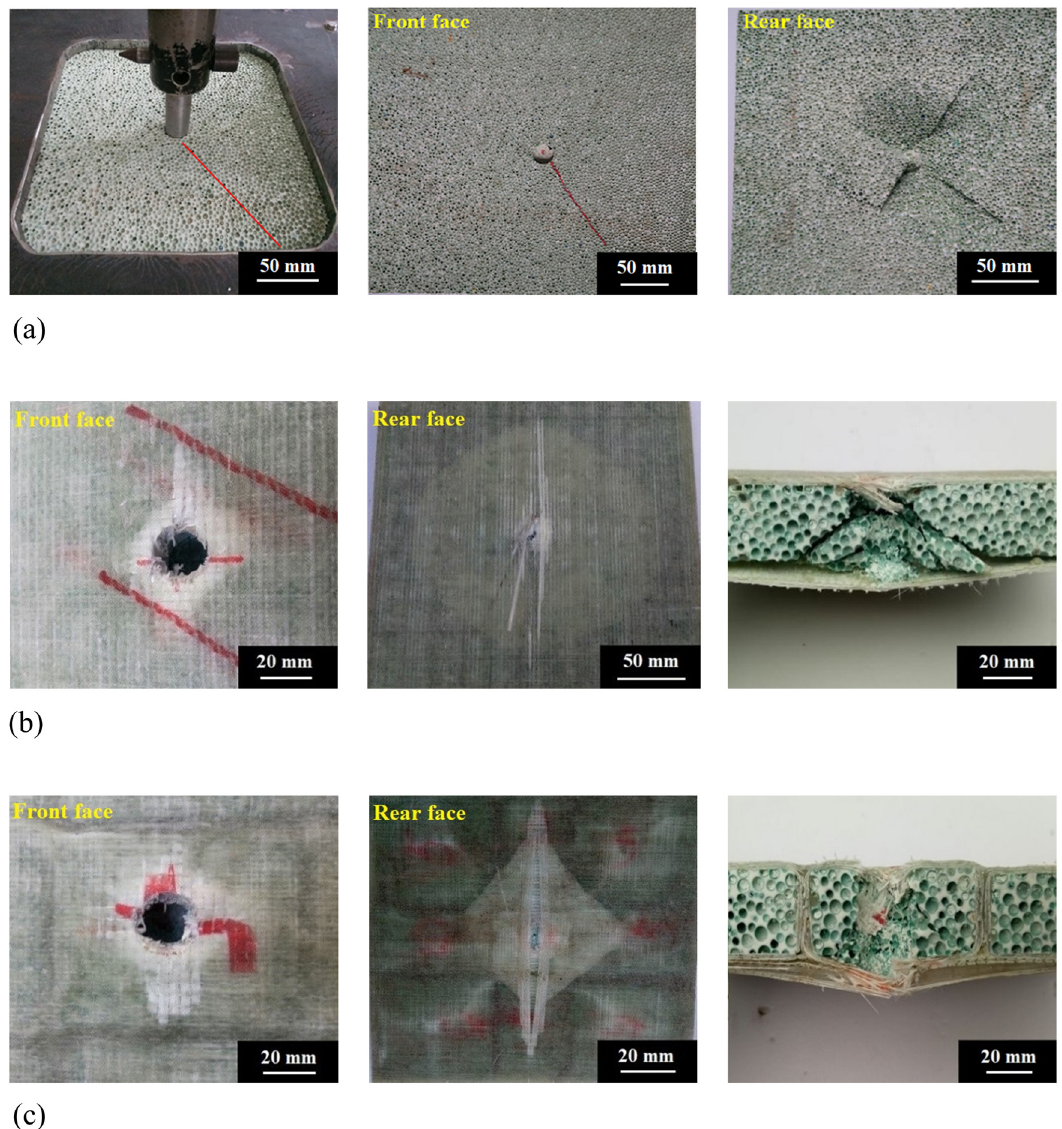
Figure 3: Damage of typical specimens. ( a ) Bare syntactic foam panels ( i.e., SD30 ) . ( b ) FRP – syntactic foam sandwich panels ( i.e., F41D30 ) . ( c ) FRP – syntactic foam sandwich panels with lattice webs ( i.e., F41D30w4 )